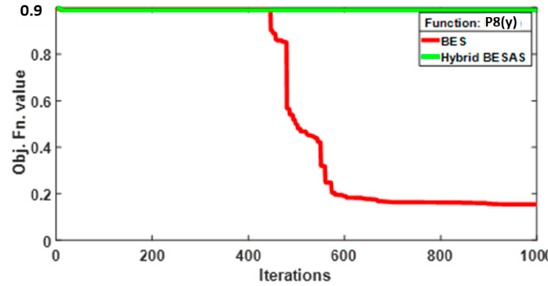
Figure 5. Convergence profile for function p 8 .